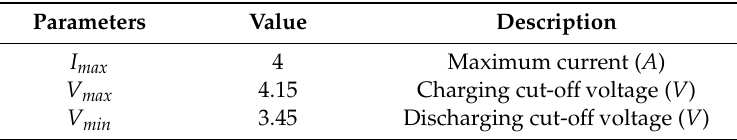
Table 3. Parameters of single battery.